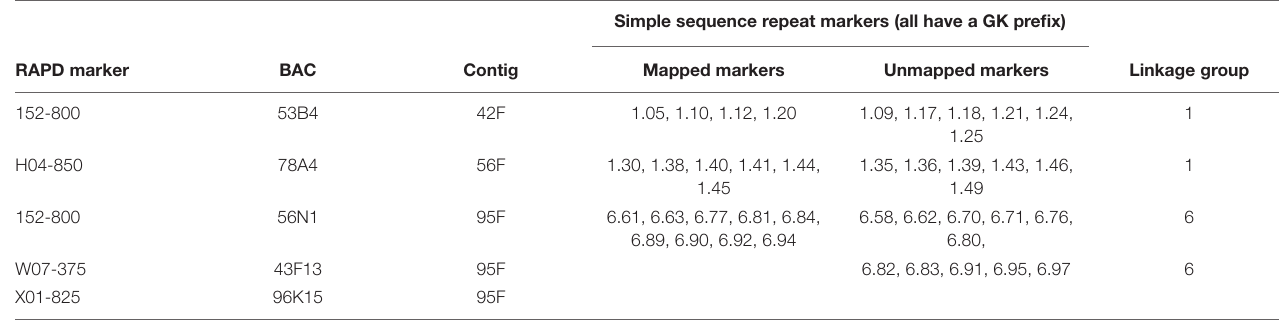
TABLE 3 | New simple sequence repeat markers developed from three contigs in the ’Jefferson’ hazelnut genome sequence (V2) and the random amplified polymorphic DNA (RAPD) marker and bacterial artificial chromosome (BAC) sequences used to identify the contigs. Simple sequence repeat markers (all have a GK